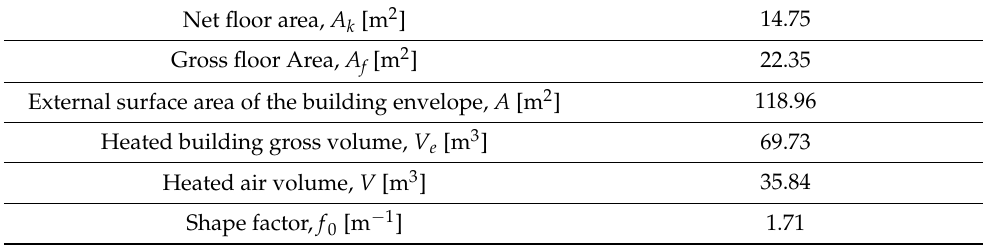
Figure 4. View of the main façade of the MUZA constructed with the LSF system. Table 1 presents the basic geometric characteristics of the MUZA used in energy balance modelling. Table 1. Geometric characteristics of the MUZA.